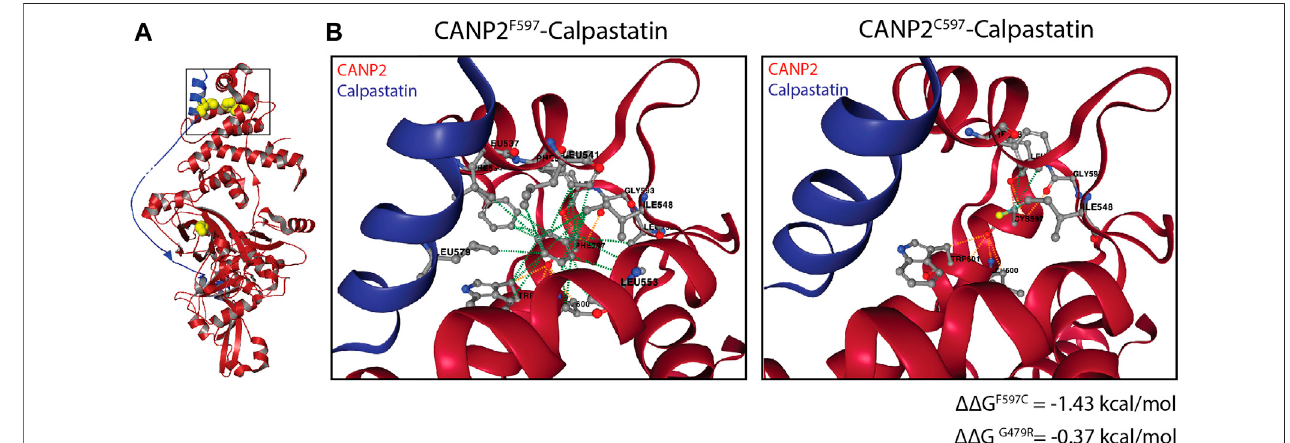
FIGURE6| Impact ofthep.G492Rand p. F610Cmissensemutations inthecalpain-calpastatininteraction. (A) Overall viewofcalpastatin-bound calpain-2(PDB: 3bow) showing the calpain molecule in red and the calpastatin polypeptide in blue. G492 and F610 residues (G479 and F597 in calpain 2) and L578 (calpastatin) are shownasyellowspheres. (B) Non-covalentinteractionsmaintainingthecalpain-calpastatincomplex,showinghydrophobic(green)andpolar(orange)betweentheF597 (calpain) and L578 (calpastatin)